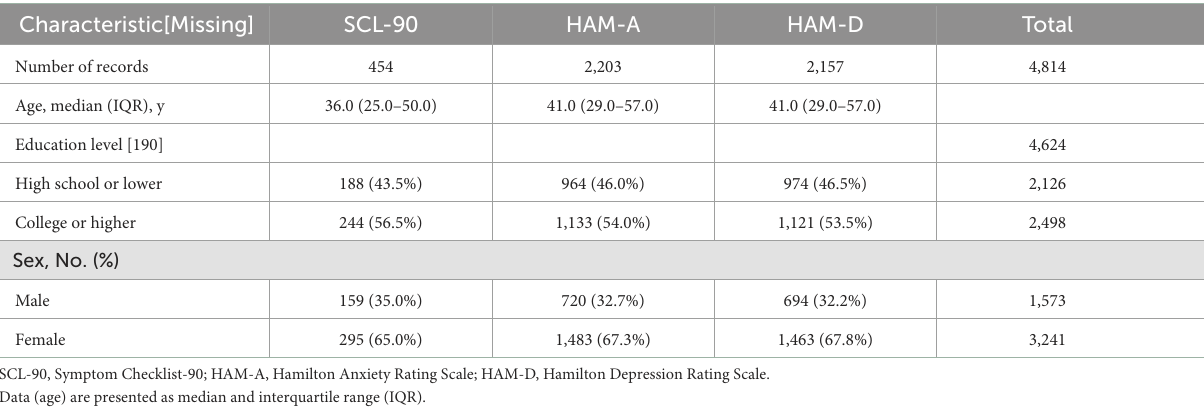
layers. XGBoost (20) is a type of gradient boosted decision tree (GBDT) that is frequently used in classification and regression tasks. Logistic regression (LR) is a common model that is used to calculate odds ratios and is competent in classification